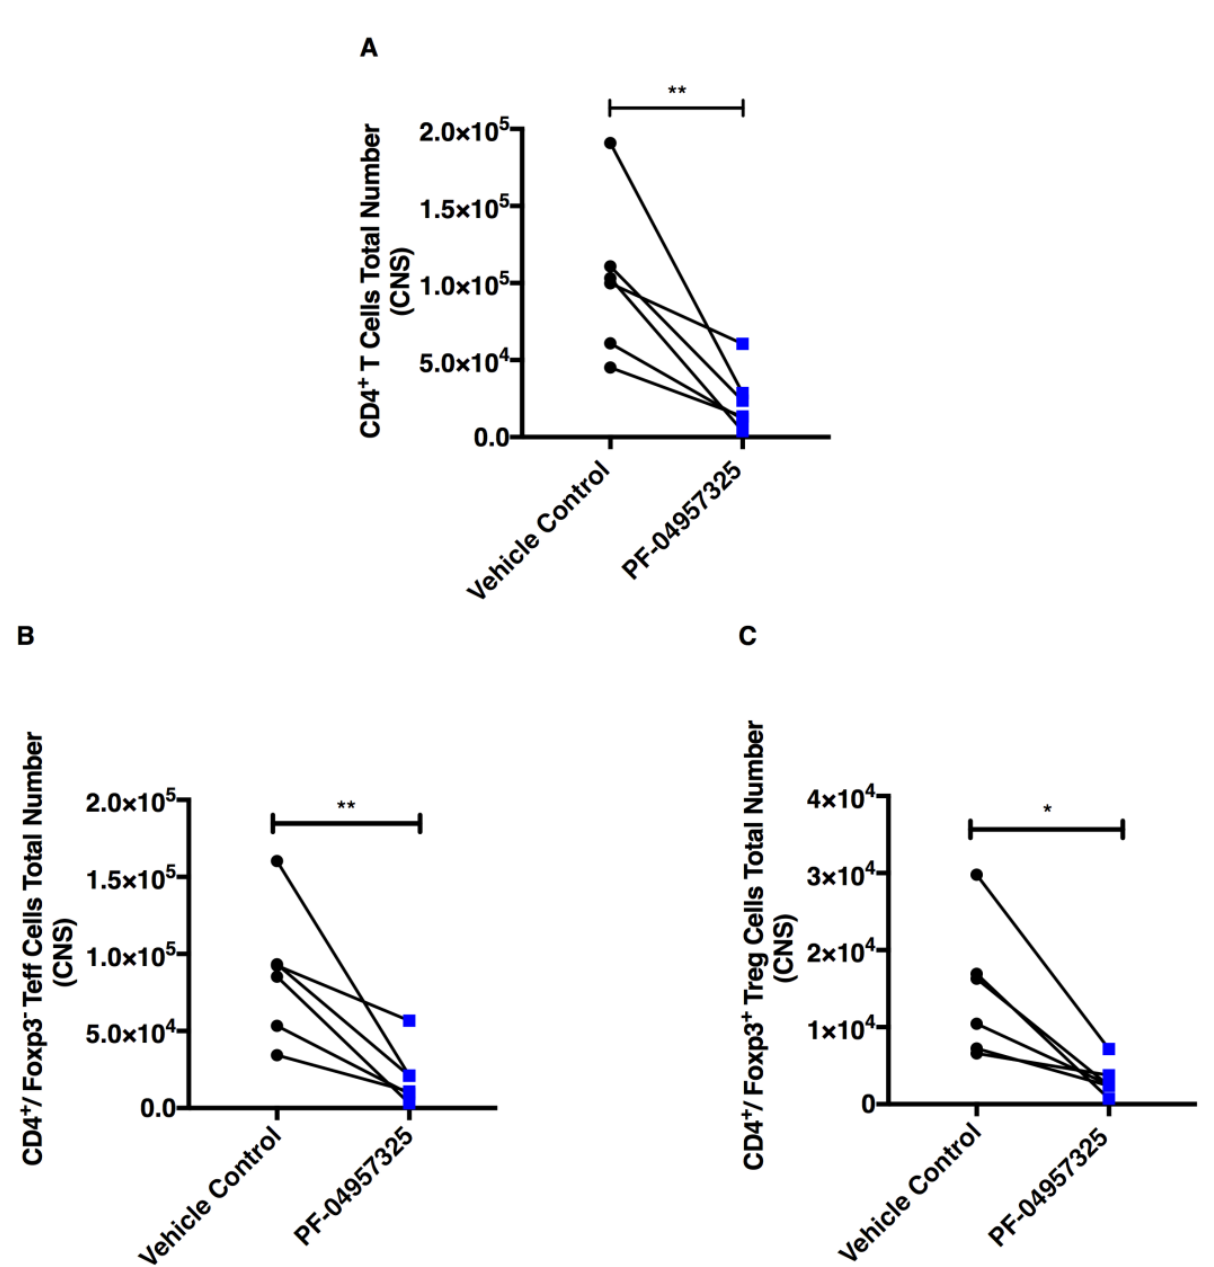
Figure 4. Treatment with PF-04957325 suppresses the accumulation of total CD4 + T cells and Teff and Treg cell subpopulations in the spinal cord. Mice with EAE scores of at least 1 were treated with the vehicle control or PF-04957325 thrice daily for 6 to 13 days. The data represent the total number of CD4 + T cells (** p = 0.006) ( A ), Foxp3 − /Teff cells (** p = 0.007) ( B ), and Foxp3 + /Treg cells (* p = 0.01) ( C ) in the spinal cord (CNS) analyzed by flow cytometry ( n = six mice per group, mean ± SEM of four independent experiments).